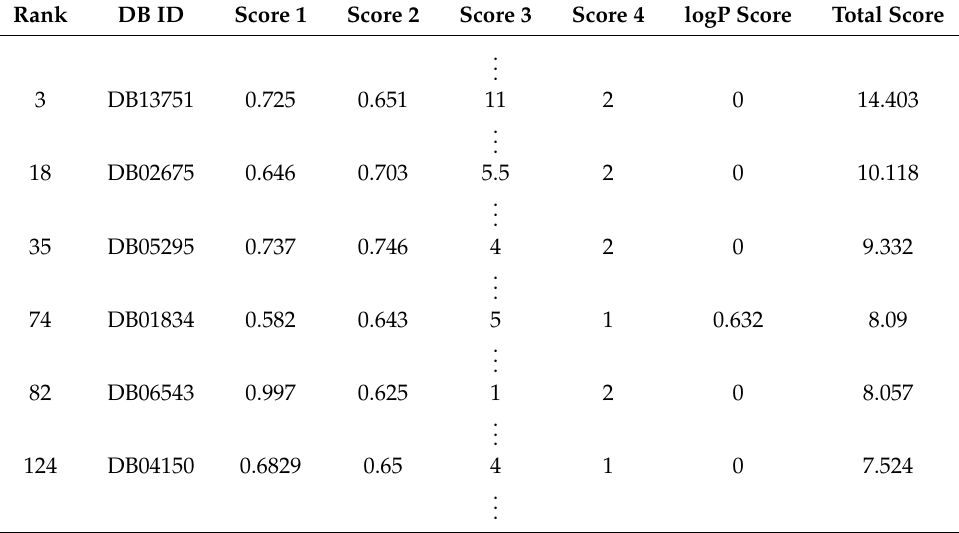
Table 1. CS scores of the molecules after qualitative examination. The rows are drugs listed in the DrugBank 5.0 database. The columns show sub-scores that constitute the CS score. Scores 1–4 mean the distance between Block A and C, within-block distance, size asymmetry between Block A and Block C, and number of head and tail atoms included in the hydrophilic group, re- spectively. The logP score is not the value of logP, and the largest value was regularized when the value of logP was 0. The following sentence indicates the official name of the DB identi- fier. DB13751:glycyrrhizic acid; DB02675:(4-hydroxymaltosephenyl)glycine; DB05295:eldecalcitol; DB01834:(9R,10R)-9-(S-glutathionyl)-10-hydroxy-9,10-dihydrophenanthrene; DB06543:astaxanthin; DB04150:threonine derivative.